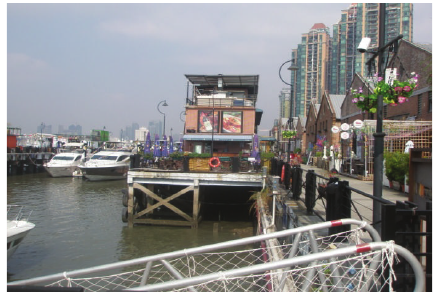
Figure 5: Riverside view of Taikoo Wharf.